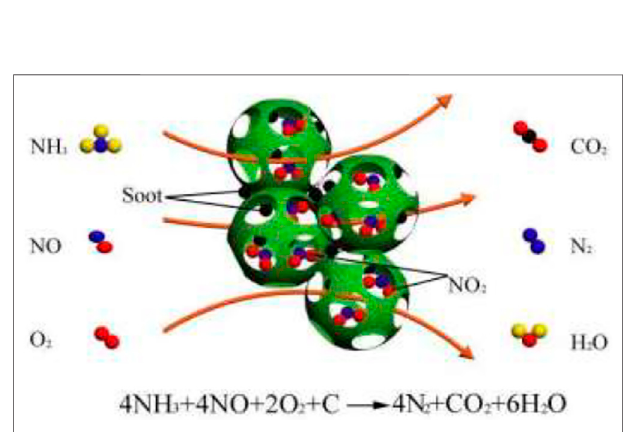
FIGURE 11 | In situ DRIFTS spectra of the W 1 CeMnO δ /ZrTiO 4 catalyst under different temperatures and reaction gases. (A) The reaction between NO + O 2 and pre-adsorbed NH 3 at 200 ° C; (B) reaction between NH 3 and pre-adsorbed NO + O 2 at 200 ° C; (C) reaction between NO + O 2 and pre-adsorbed NH 3 at 300 ° C; (D) reaction between NH 3 and pre-adsorbed NO + O 2 at 300 °